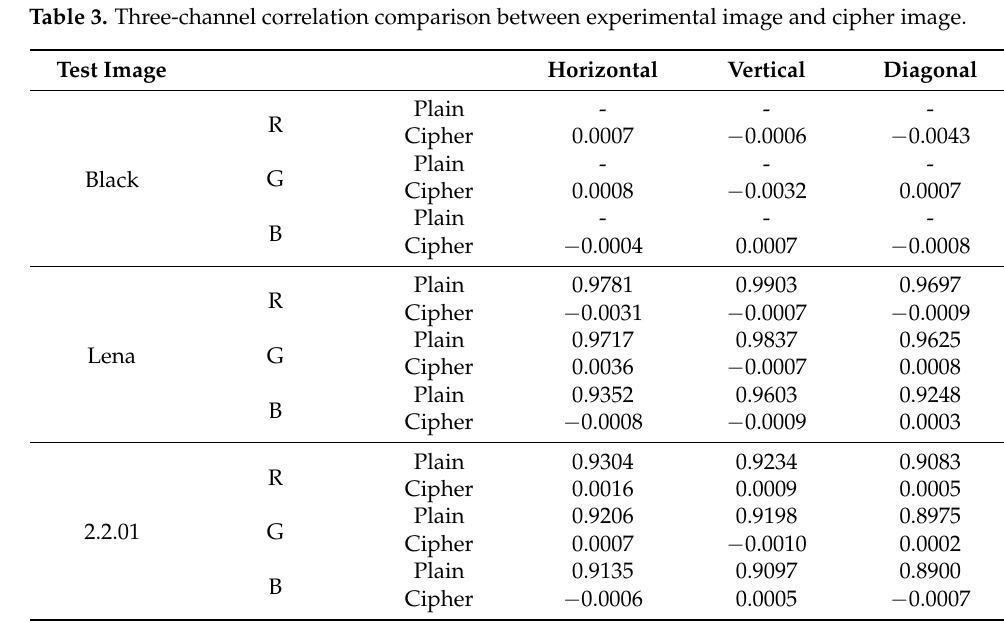
Figure 10. Image correlation before and after encryption. ( a ) Plain image correlation. ( b ) Cipher image correlation.